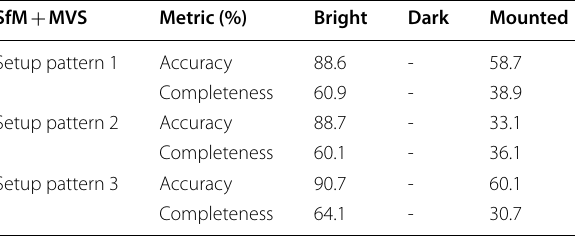
Table 12 Performance comparison of SfM different illumination conditions and setup patterns